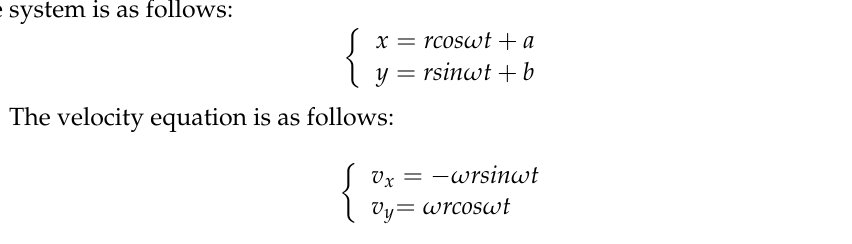
Figure 4. Motion diagram of driving components and seed filling box mechanism.